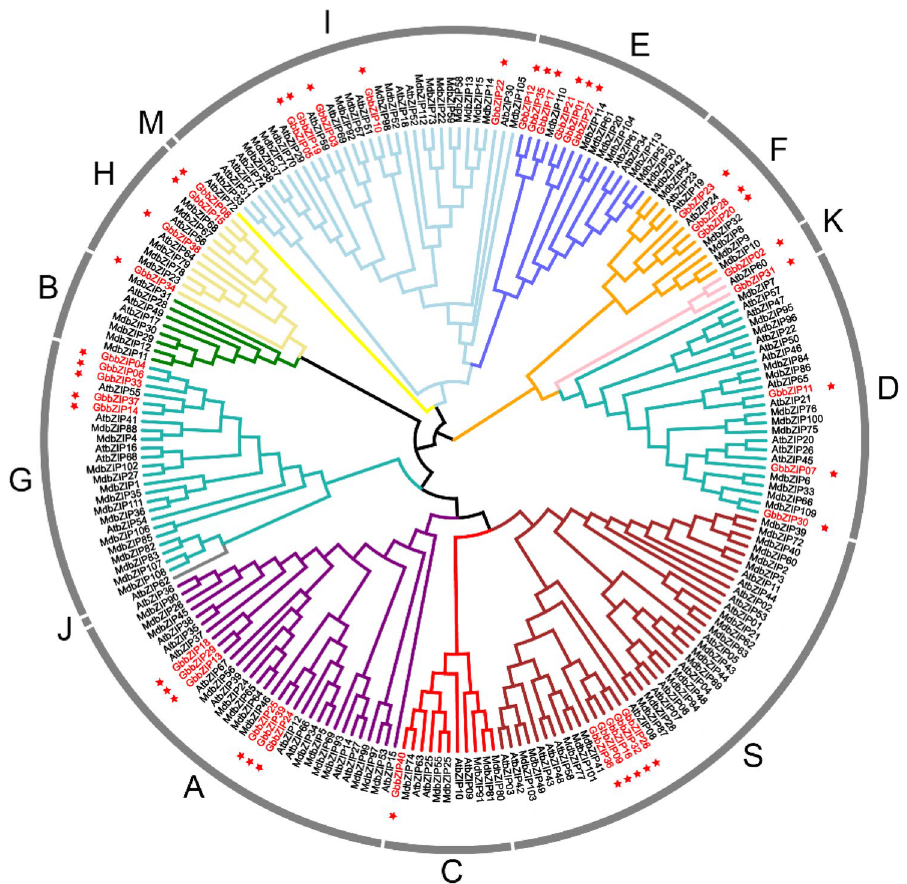
Figure 3. Phylogenetic tree based on G. biloba , A. thaliana and M. domestica bZIP proteins. MUSCLE in MEGA 6.0 was used for multiple sequence alignments of bZIP conserved domain sequences 31,32 . The